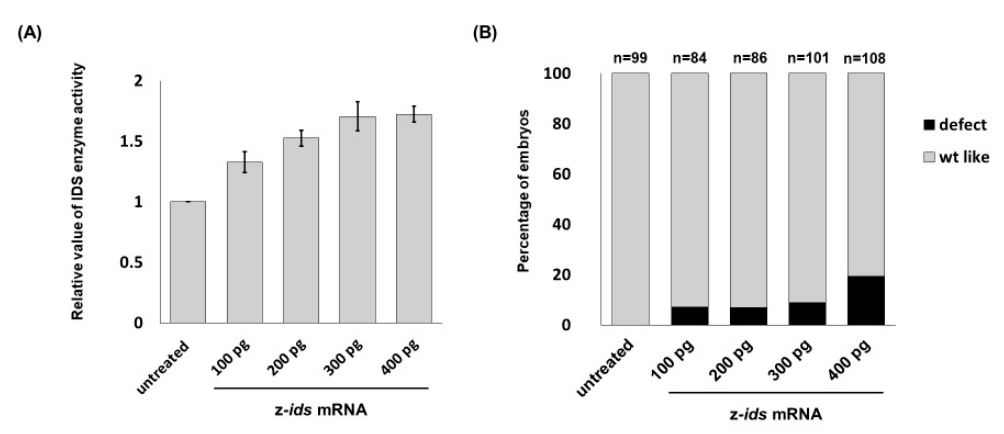
Figure 1. Enzymatic activity of iduronate 2-sulfatase (IDS) and the occurrence rate of developmental defects in zebrafish embryos injected with di ff erent concentrations of z- ids mRNAs. ( A ) Zebrafish embryos at one-cell stage were injected with 100-, 200-, 300-, or 400-pg of z- ids mRNAs, followed by detection of IDS enzymatic activity at 48 hpf. The IDS enzymatic activity of the untreated control group was normalized as 1 for comparison with the embryos injected with di ff erent dosages of z- ids mRNAs. ( B ) The occurrence rates (in percentage) of defective phenotypes among zebrafish embryos injected with 100-, 200-, 300-, and 400-pg, z- ids mRNAs were calculated when embryos were examined at 5 dpf.